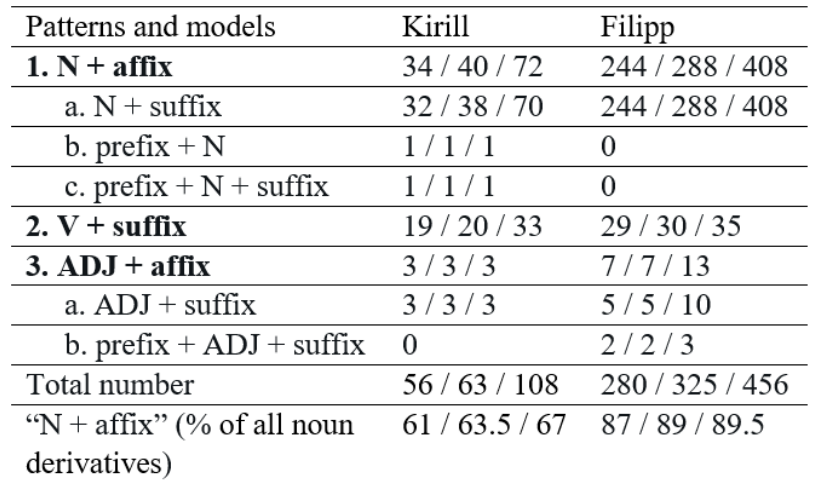
Table 3. Early nominal derivational patterns and models in CS ( lemmas / types / tokens